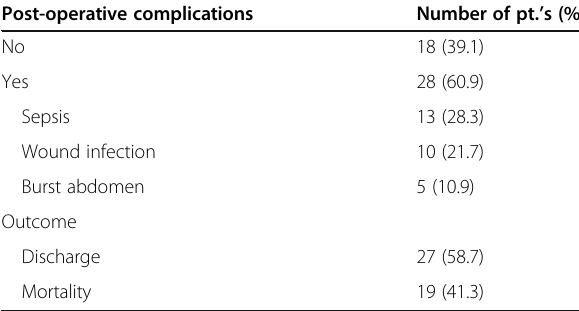
Table 3 Postoperative events in patient Post-operative